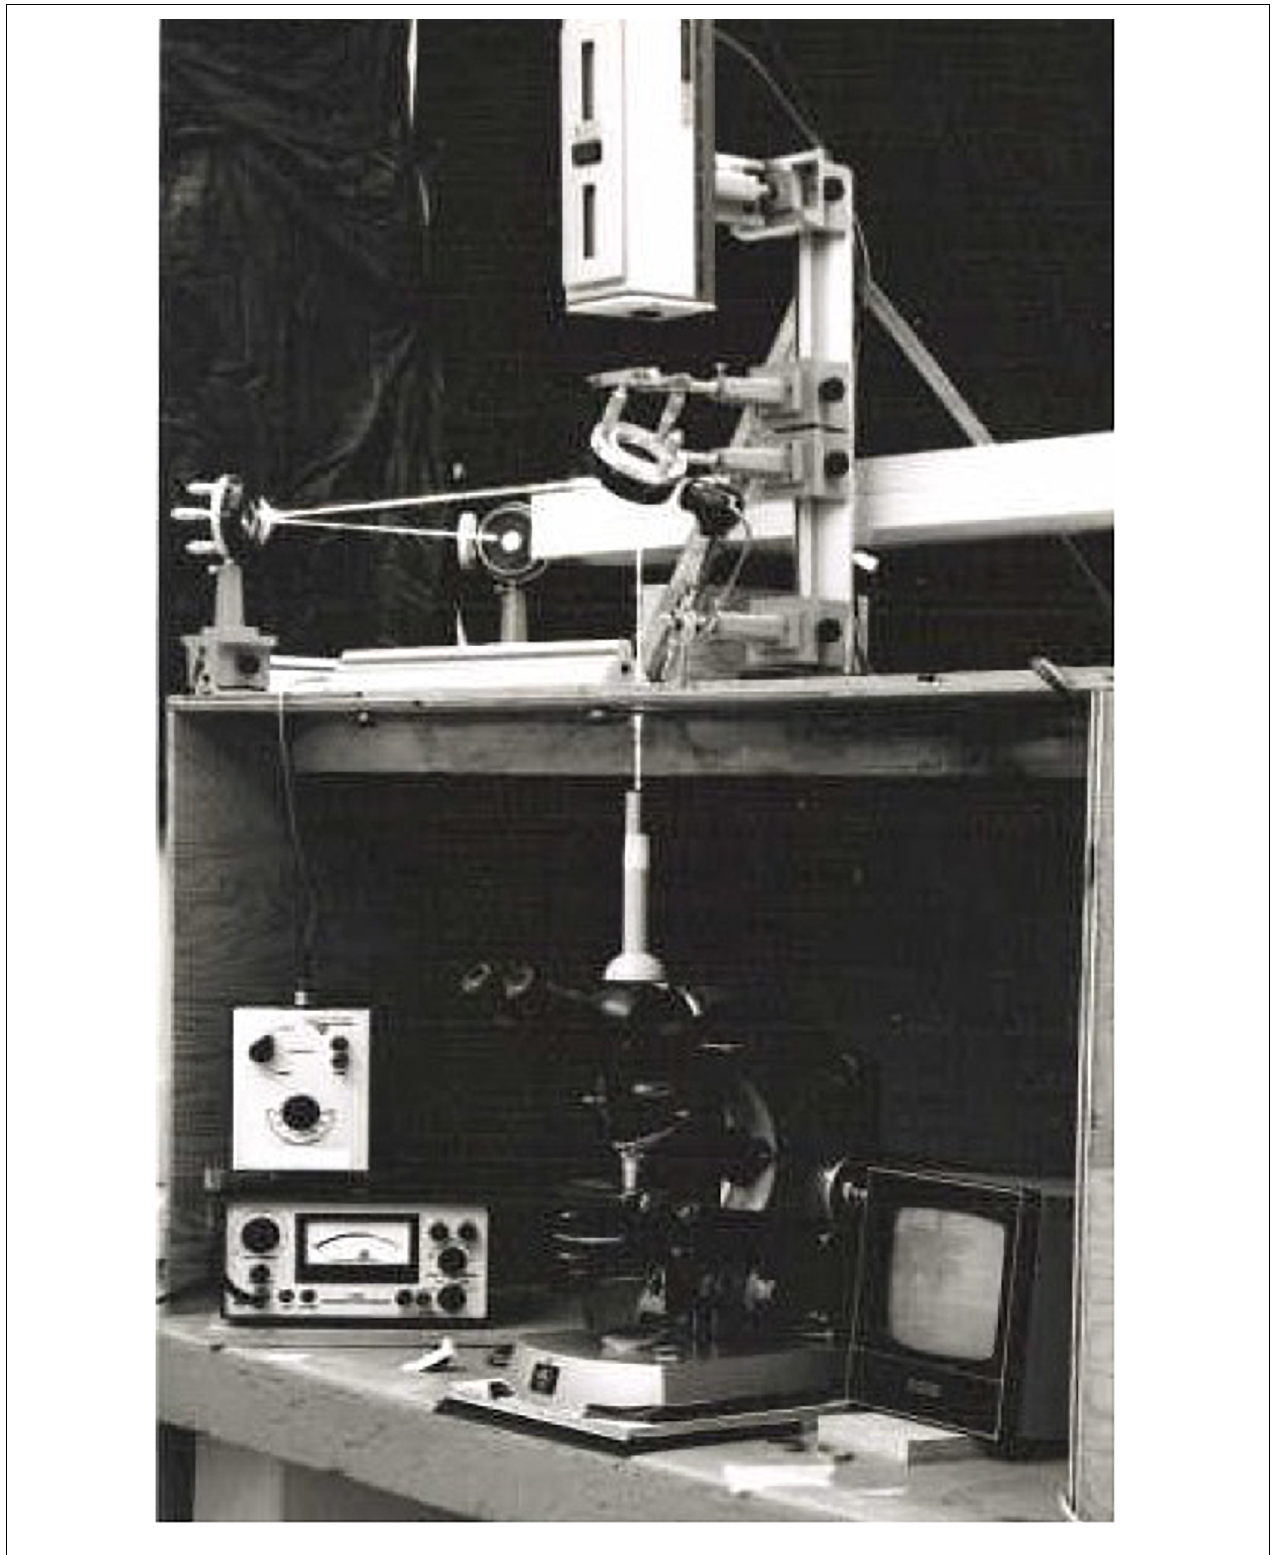
FIGURE 3 | Argon ion laser microbeam depicted in Figure 2 (University of Michigan, Ann Arbor, 1971). This system was used for experiments from 1970 to 1979.